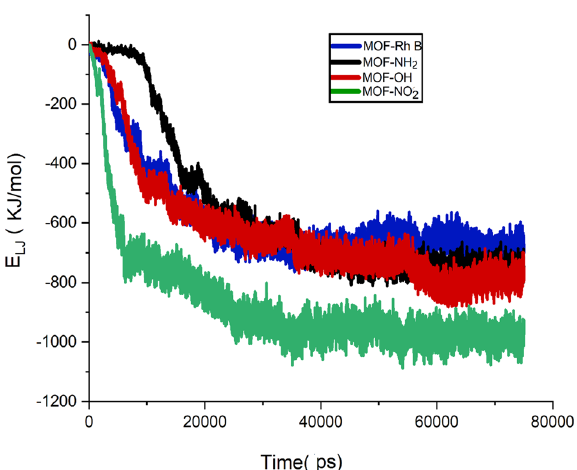
Fig. 2 Interaction energy of the dye molecules with MOF (blue), MOF-NH2 (black), MOF-OH (red), and MOF-NO2 (green) as a function of simulation time.